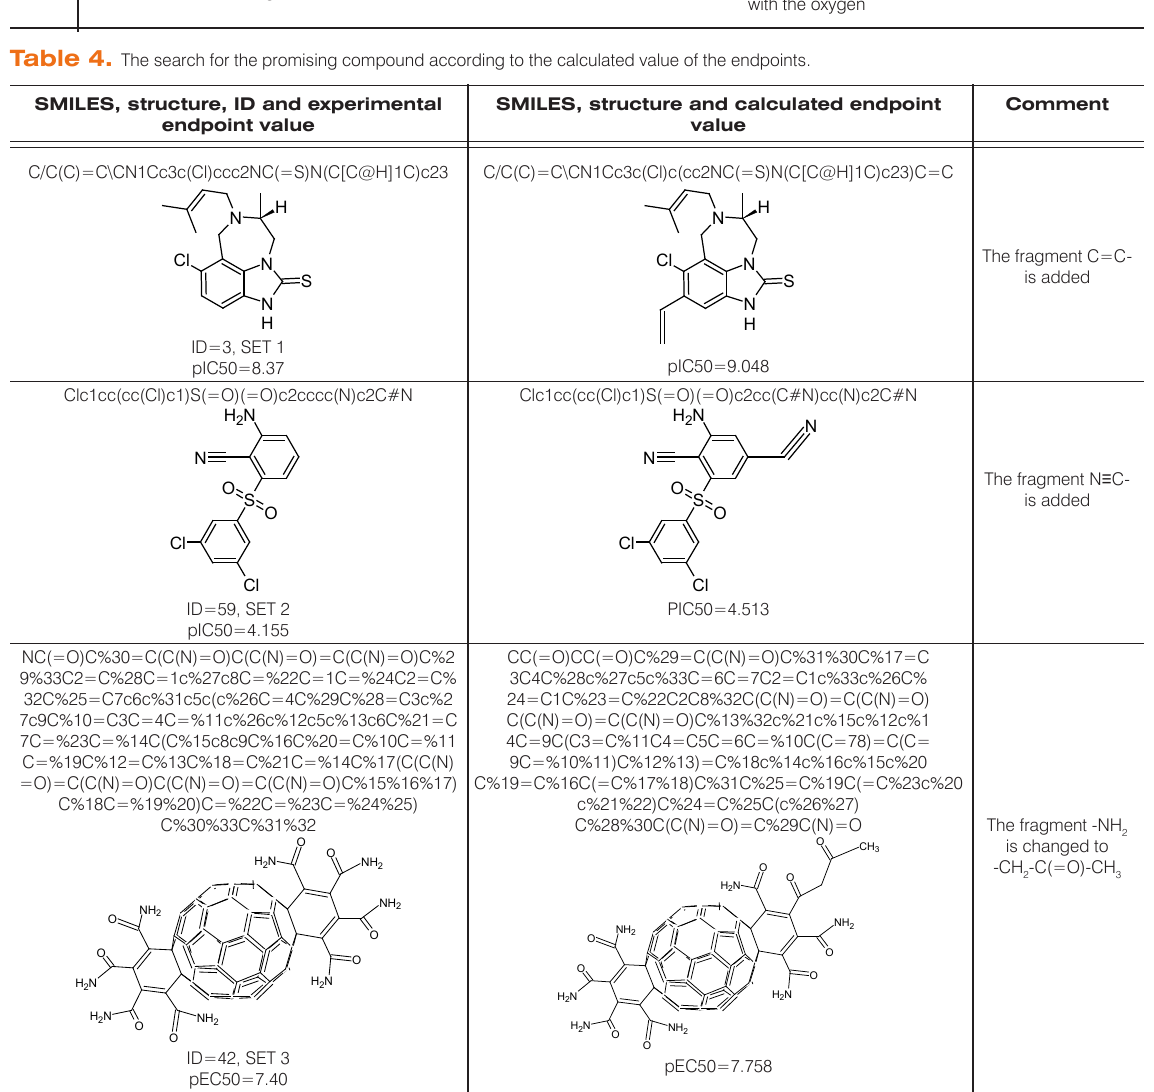
Table 4. The search for the promising compound according to the calculated value of the endpoints. SMILES, structure, ID and experimental endpoint value